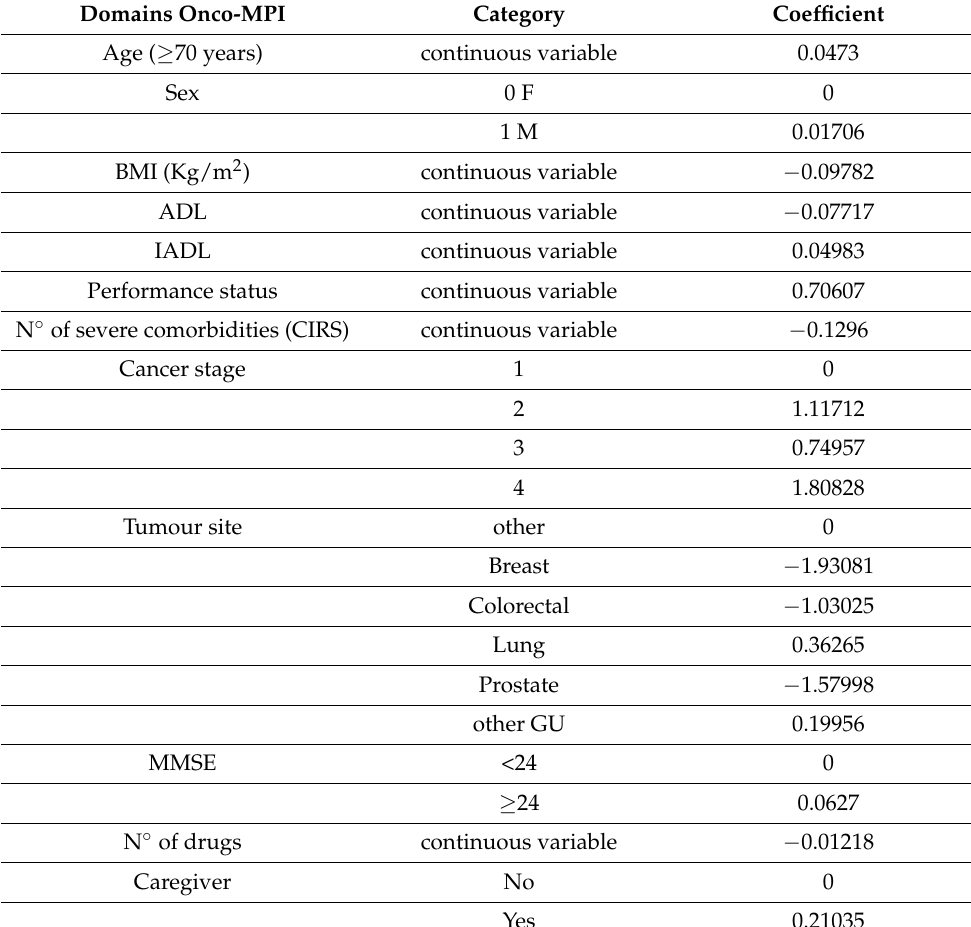
Table 2. Onco-MPI algorithm